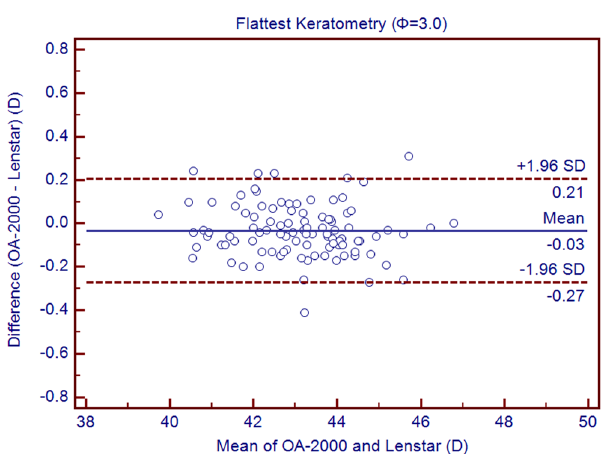
Figure 12. Bland-Altman plots show the agreement between OA-2000 swept-source optical coherence tomography and Lenstar optical low coherence reflectometry for measuring flat keratometry (Kf) at 3.0 mm. Solid lines represent the bias between both devices and dotted lines represent at the 95% confidence interval for the